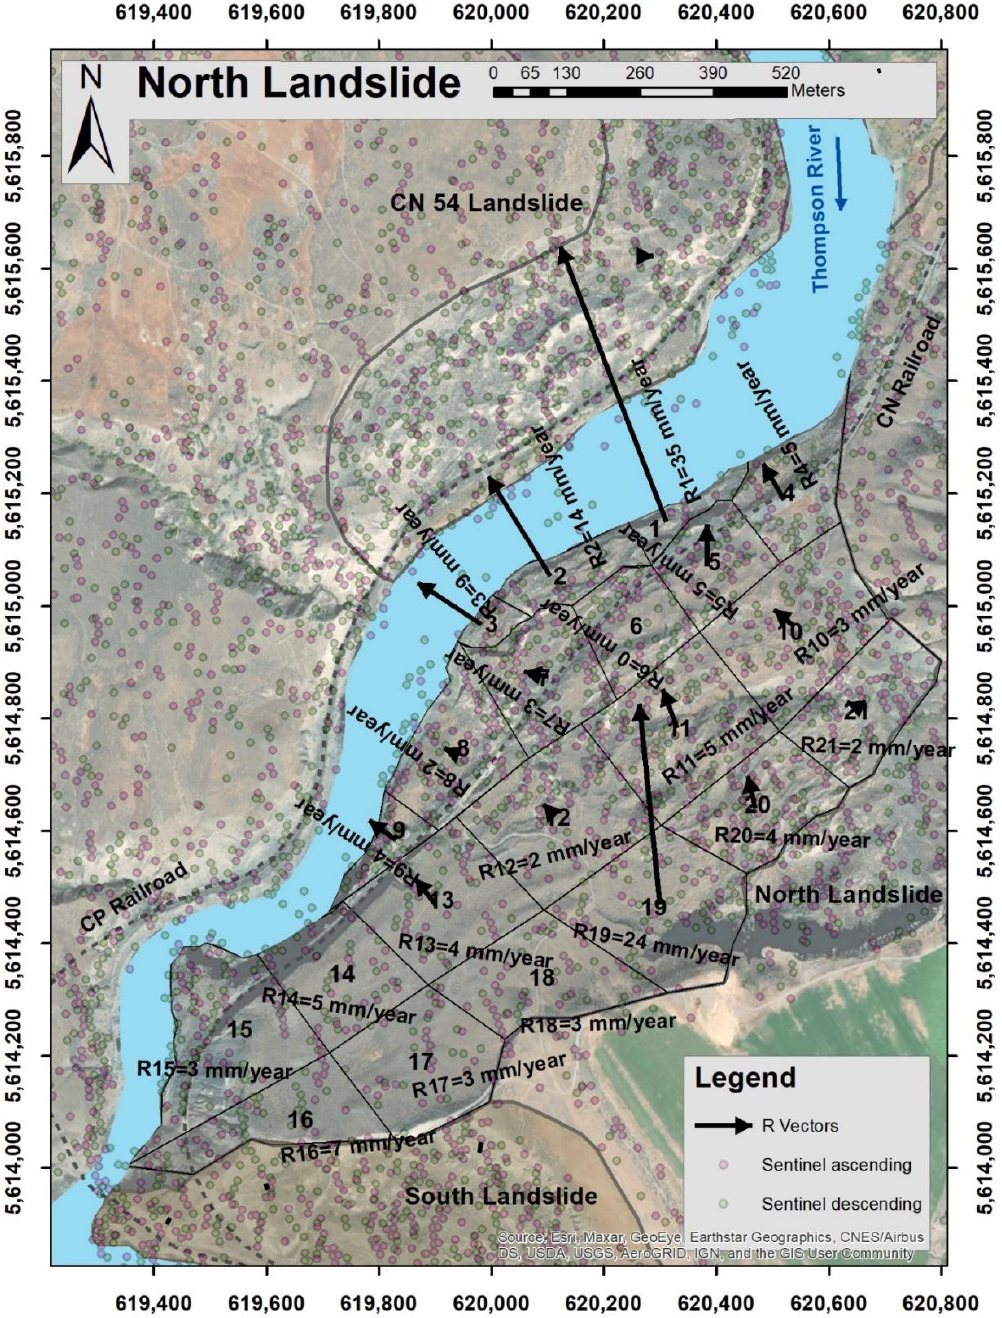
Figure 10. Calculated horizontal component of R for all sectors of the North landslide.